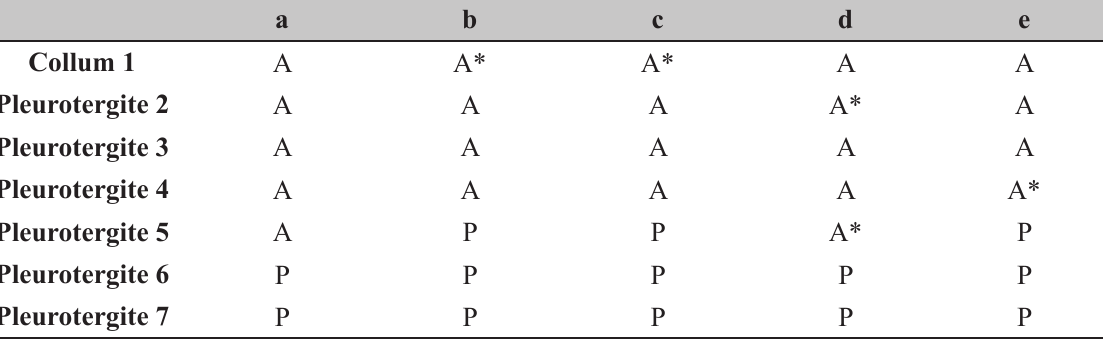
Table 1. Chaetotaxy of the first seven rings (pleurotergites) of Lusitanipus xanin sp. nov. Setae order (a–e), reflects proximity to sagittal plane, with (a) being the closest. (A) means anterior, (A*) means that it is close to the anterior position or in the middle, and (P) means